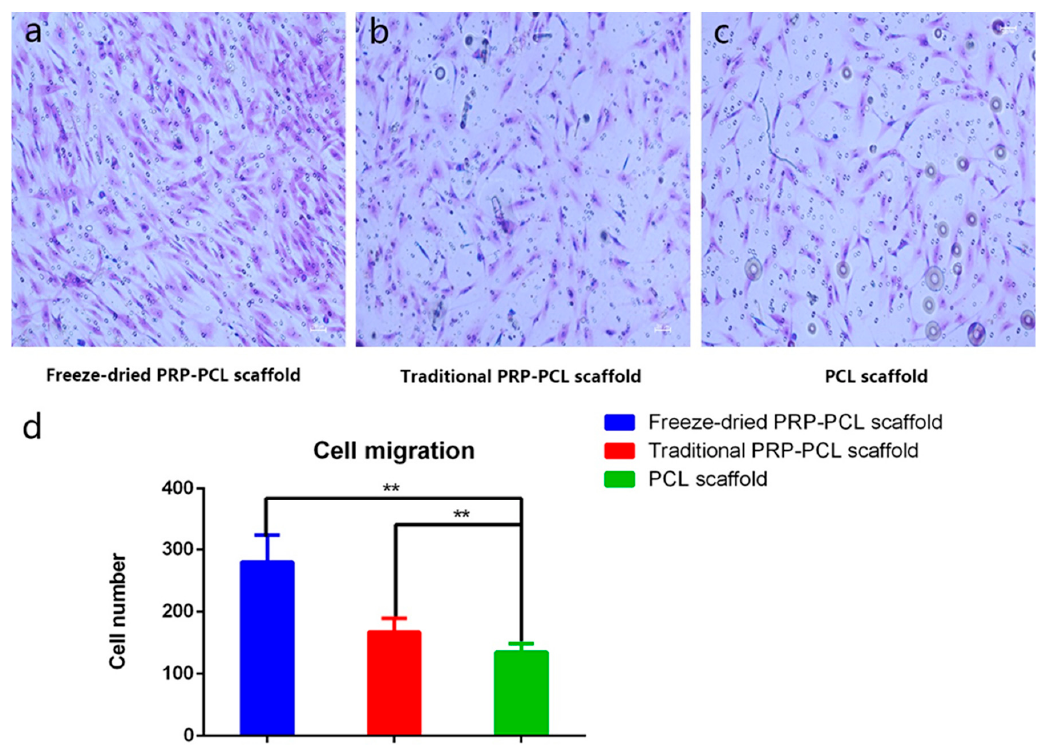
Figure 5. Number of migrated cells in the ( a ) freeze-dried PRP-PCL scaffold group; ( b ) traditional PRP-PCL scaffold group; ( c ) bare PCL scaffold group after 12 h of seeding; all images shown at ×50 magnification (** p < 0.01) and ( d ) The number of the cell migration.